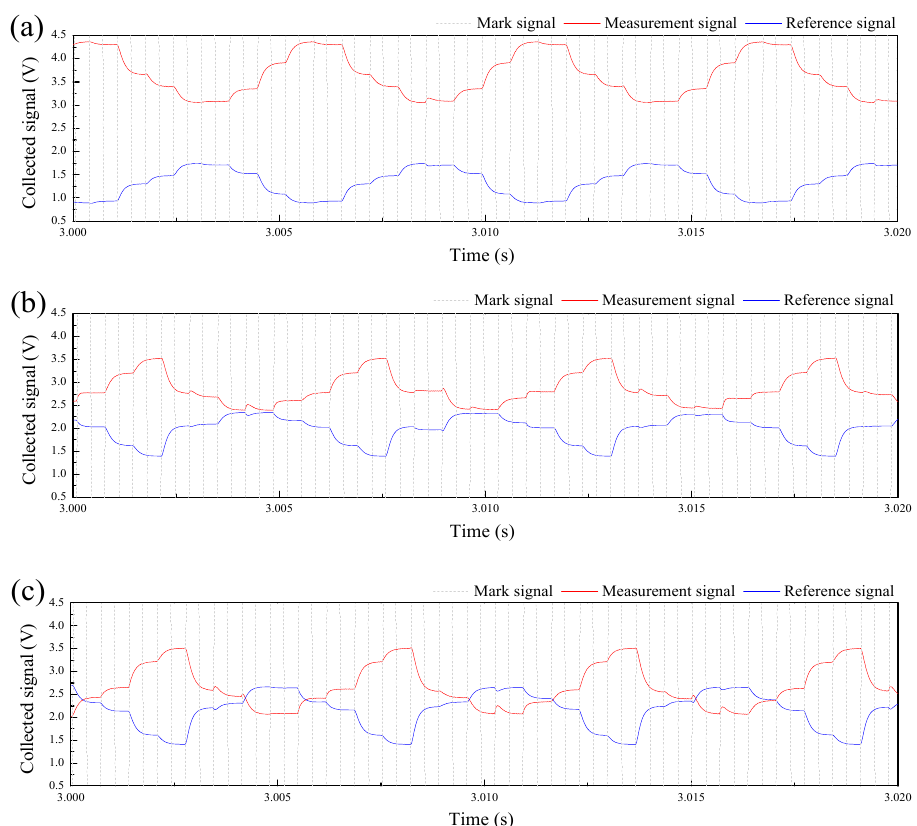
Figure 10. PLIF images for the flow conditions in the +3° inclined pipe: ( a ) Usa = 0.052 m/s, Uso = 0.15 m/s, ST flow; ( b ) Usa = 0.222 m/s, Uso = 0.15 m/s, ST flow; ( c ) Usa = 0.393 m/s, Uso = 0.15 m/s, ST&MI flow.